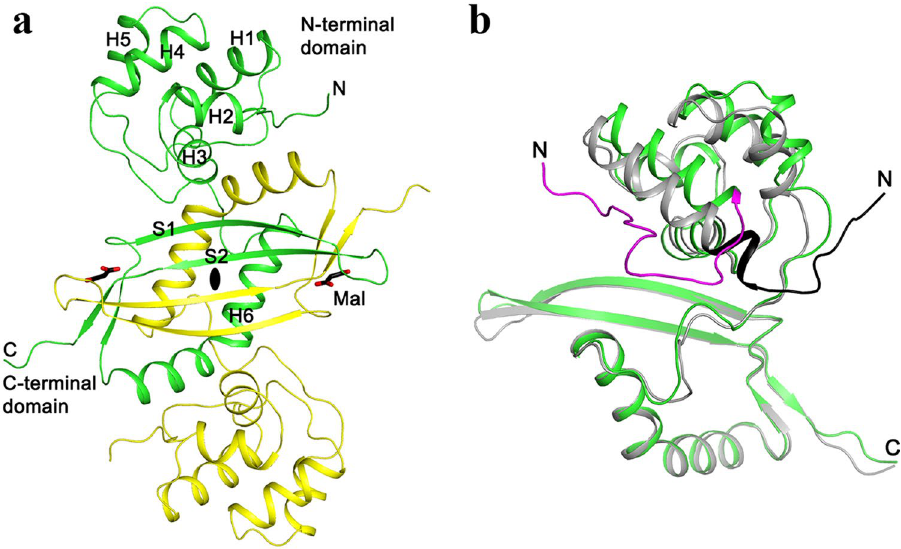
Figure 1. Structure of fungal cyanase dimer. ( a ) An intertwined C-terminal domain (residues 92–160) in the dimer structure of T. lanuginosus cyanase (Tl-Cyn). The two monomers are colored in yellow and green, and the two-fold axis of the dimer is indicated by the black oval. The two malonate molecules bound to the active sites of the dimer are shown as sticks, colored according to atom types (carbon black, and oxygen red) and labeled Mal. Each monomer contains six α-helices and two anti-parallel β-strands, labeled as H1–H6 and S1–S2, respectively. ( b ) Overlay of the structure of Tl-Cyn monomer (green) with that of E. coli cyanase (gray). Large structural differences are seen for the N-terminal domain. Especially, the N-terminal segments run in opposite directions in the two structures and are highlighted in magenta and black. The structure figures were produced using PyMOL (http://www.pymol